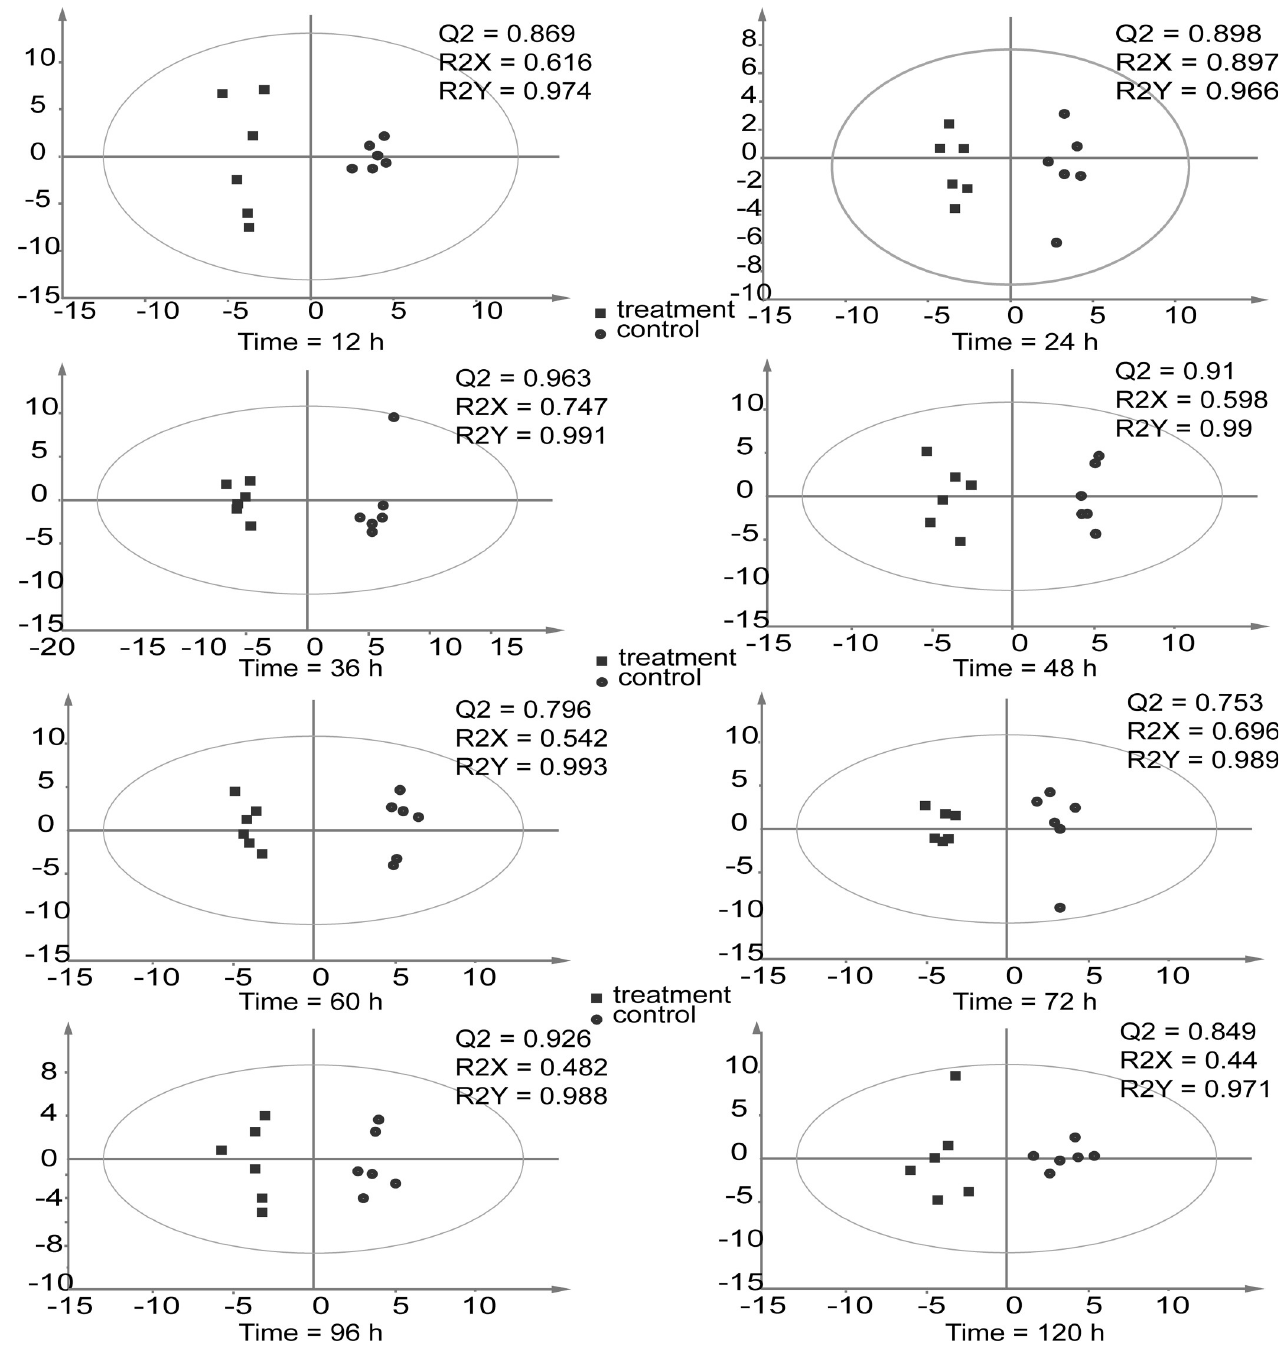
Fig 6. OPLS-DA of the treatment (cut) and control (uncut) groups of U . prolifera at different time points. UV scaling was selected; ■ and• represent the treatment(cut) and control (uncut) groups,